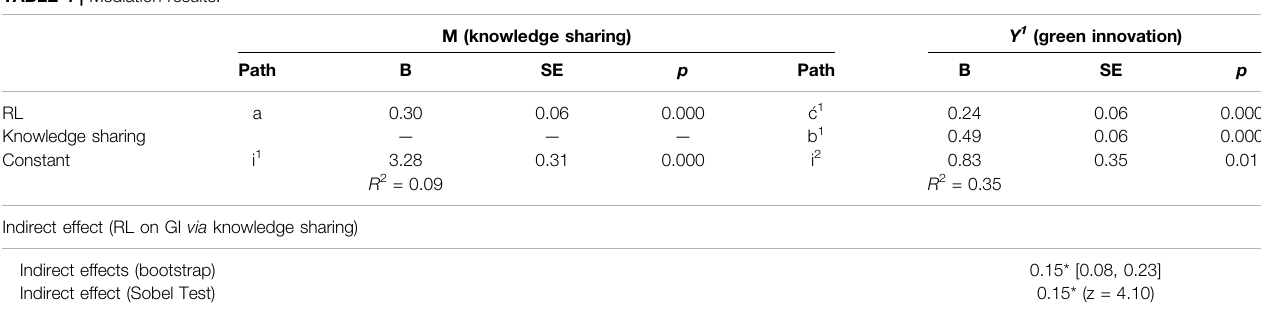
TABLE 4 | Mediation